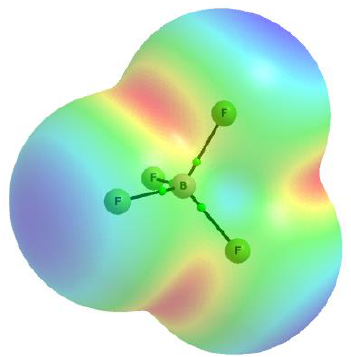
Figure 5. The electrostatic potential (EP) map calculated at the 0.001 au molecular surface for the BF 4 − anion; from the EP minimum (red) to maximum (blue) values, there are four EP minima for the anion situated at bisectors of F-B-F angles (three are noticeable in the figure).